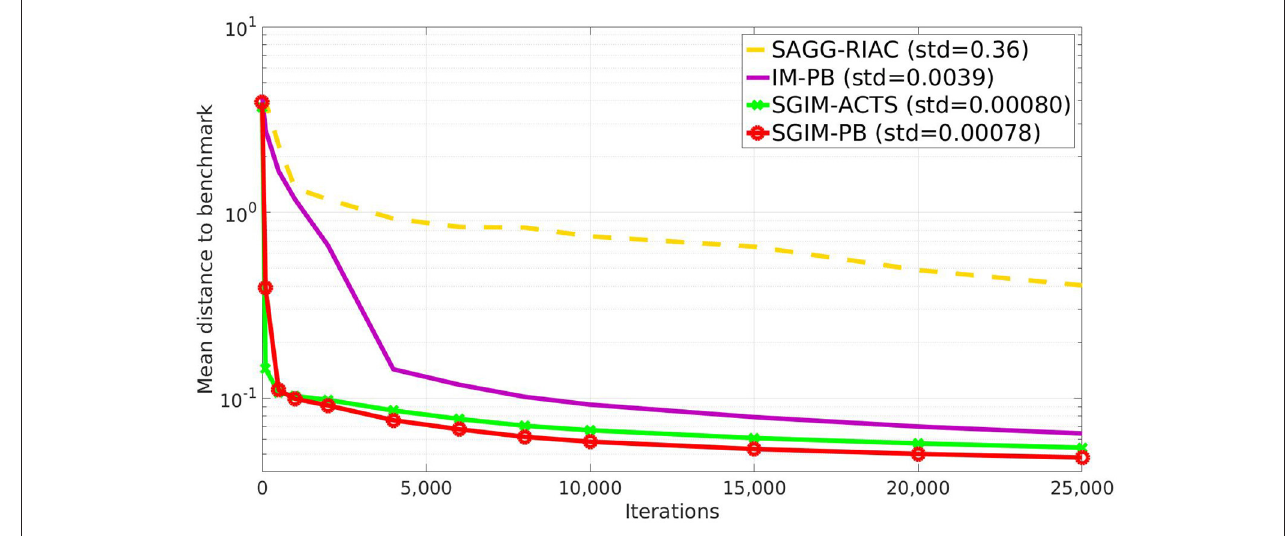
FIGURE 4 | Evaluation of all algorithms (final standard deviation shown in caption).